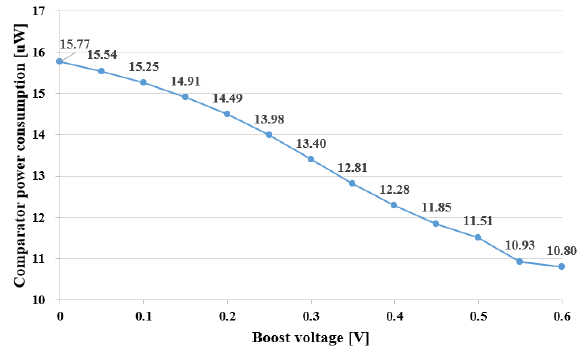
Figure 25. Power consumption of the proposed comparator with different boost